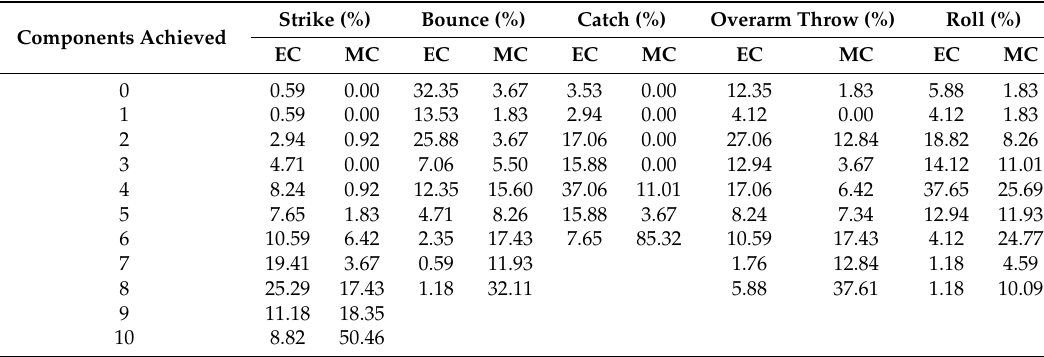
Table 3. Component achievement (%) of locomotor skills during early-childhood (EC) and middle-childhood (MC).